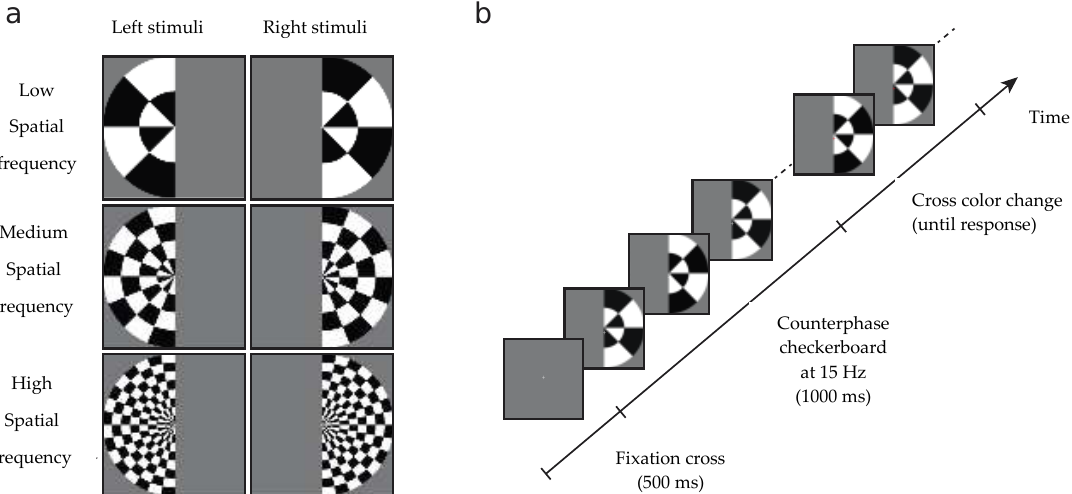
Figure 1. Stimuli and design of the experiment. ( a ) Stimuli were low, medium or high spatial frequency checkerboards presented in the left or right visual field. ( b ) A central grey fixation cross was presented for 500 ms, then the checkerboard stimulus counter-phased at 15 Hz to generate a steady state visual evoked potential paradigm (SSVEP). After 1000 ms, the cross became red or green, at which time participants discriminated its color and responded via a key-press.